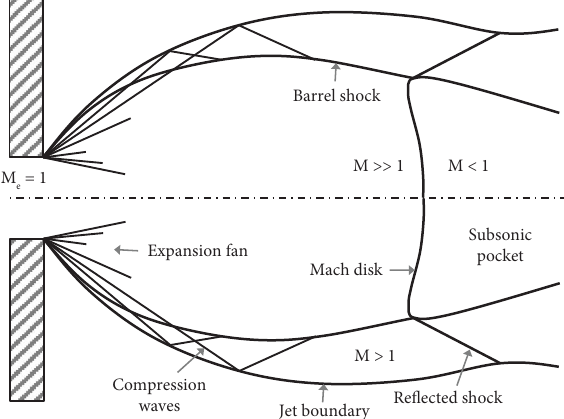
Figure 1: Schematic of a supersonic underexpanded